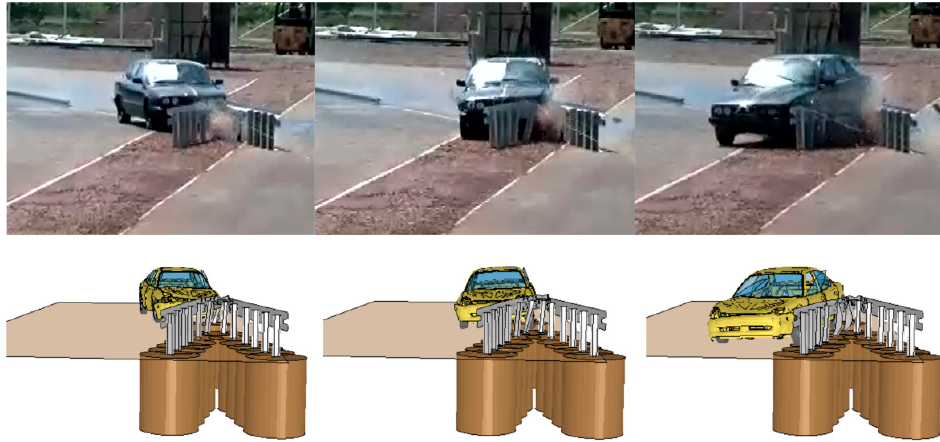
Figure 6. Comparison of the real test ( top ) with the numerical simulation ( bottom ), top down view.